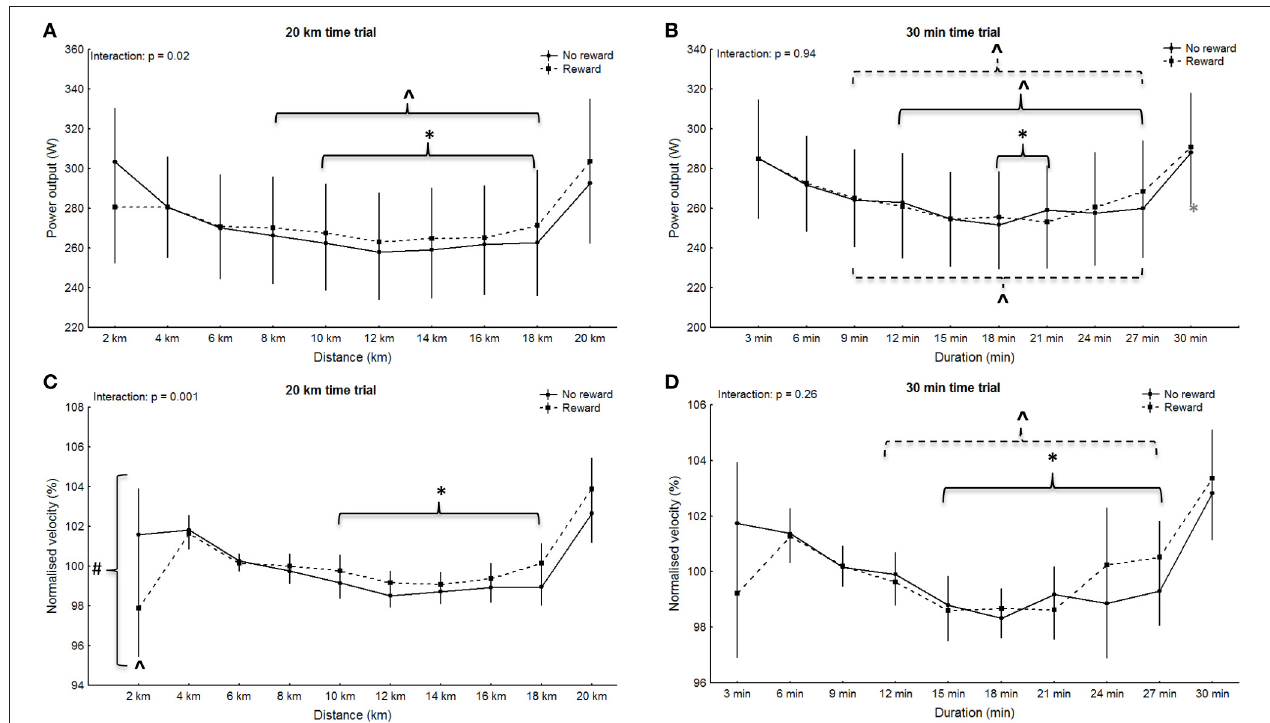
FIGURE 2 | Pattern of power output (A,B) with corresponding normalized pacing (C,D) during the 20 km (A,C) and the 30min (B,D) time trials. Means ± standard deviation. Solid line, non-rewarded; dotted line, rewarded. * indicates a significant within-trial difference to split one; ∧ indicates a significant within-trial difference to the last split; # indicates a significant effect between groups at this split.